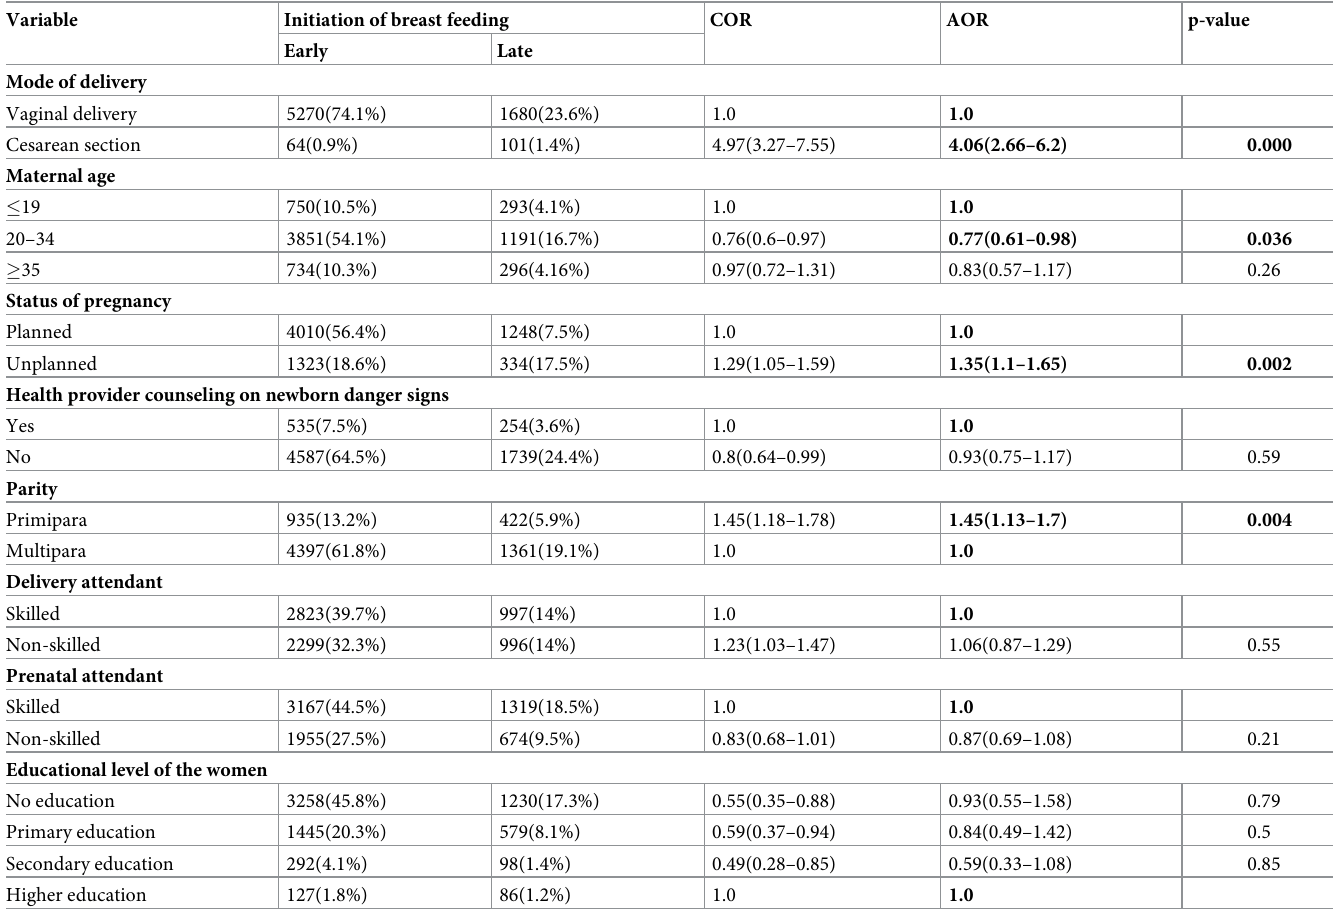
Table 3. Univariable and multivariable logistic